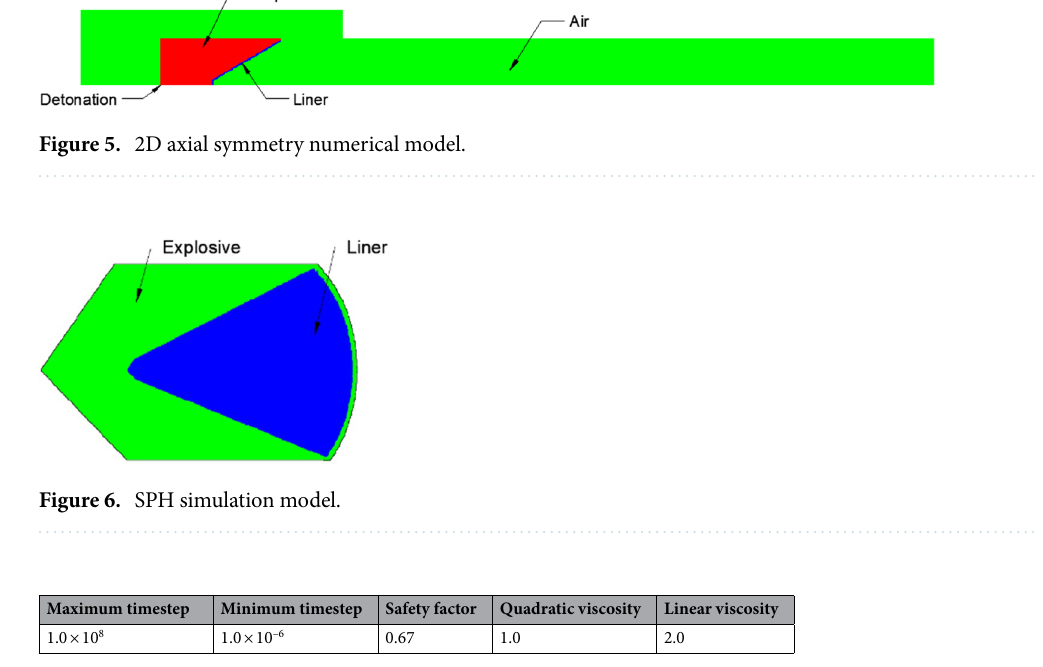
Table 2. Control parameters of the